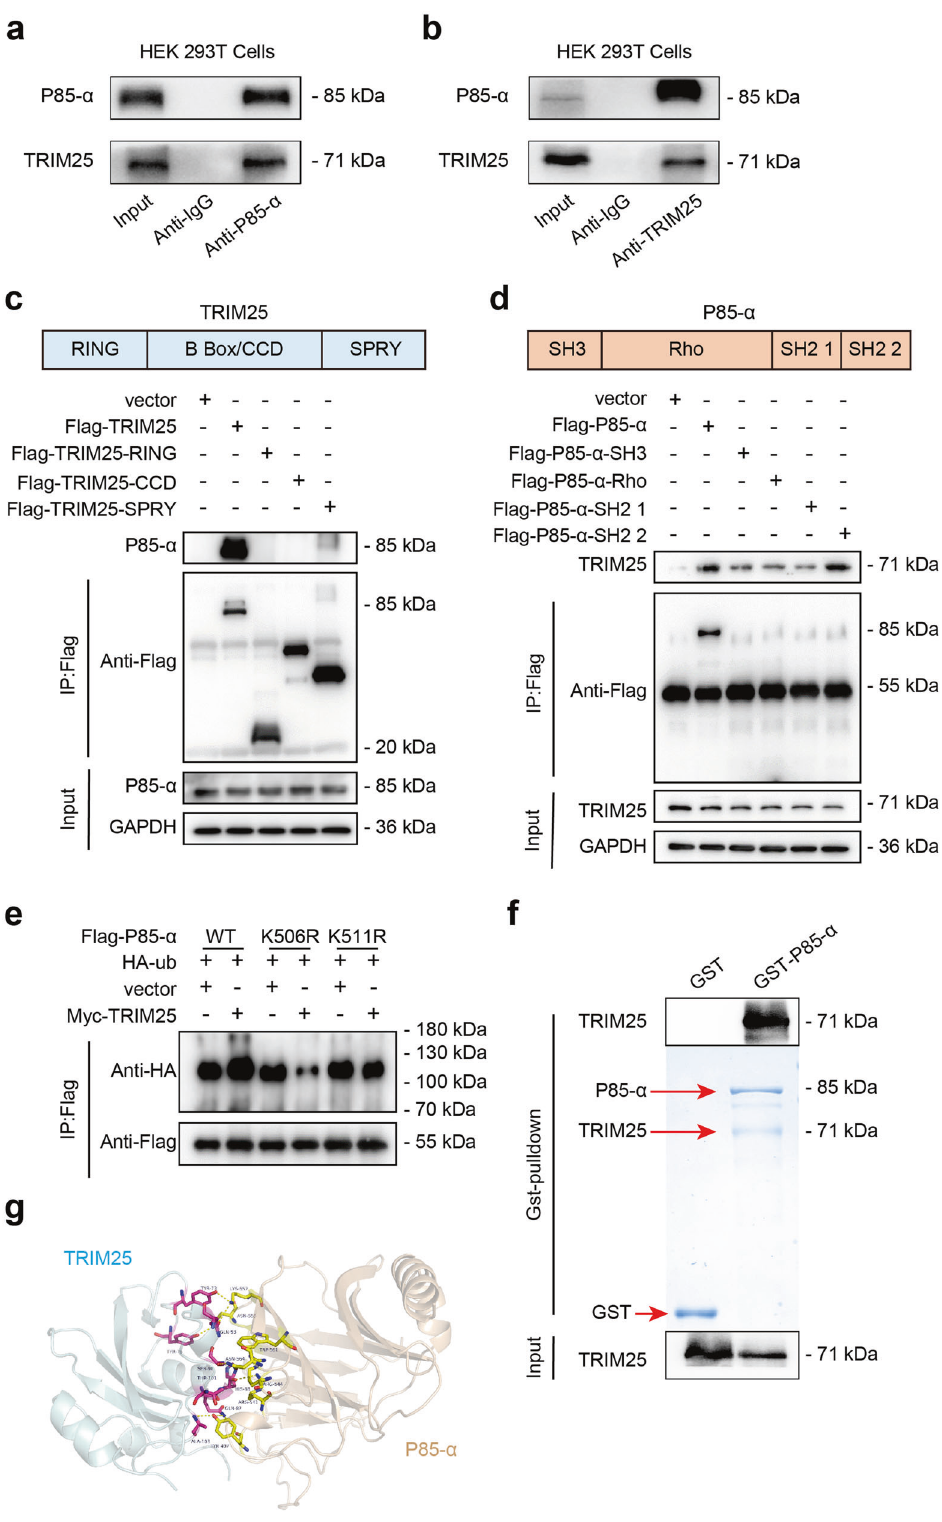
Fig. 3 TRIM25 interacts and ubiquitinates p85 α . a, b CO-IP assay of TRIM25 and p85 α were performed to investigate the interactions between TRIM25 and p85 α in HEK293 cells. c HEK293 cells overexpressing full-length and TRIM25 truncates (The RING zinc- fi nger (R), B-Box/ coiled-coil (CC) and SPRYdomain of TRIM25) were immunoprecipitated with the indicated antibody. d HEK293 cells overexpressing full-length or truncated p85 α were immunoprecipitated with the indicated antibody. e Immunoblot analysis of the ubiquitination of wide-type and p85 α mutations (K506R and K511R) with the indicated antibodies. f TRIM25 directly binds to p85 α . Glutathione S-transferase (GST) – fused p85 α and His-fused TRIM25 recombinant proteins were co-incubated and subjected to GST pulldown. g Computational molecular docking simulation analyses of TRIM25 to p85 α .